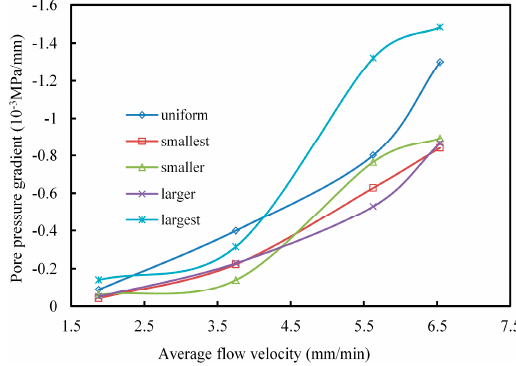
Figure 11. Relation of pore pressure gradient with flow velocity at axial displacement 10 mm.